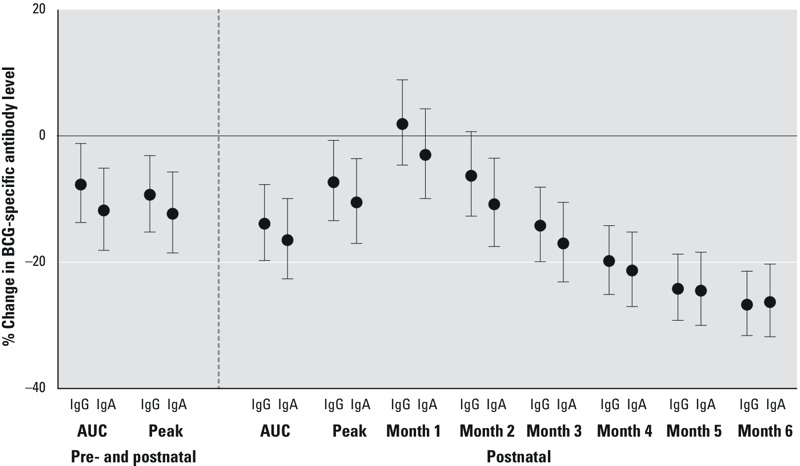
Estimated PCB concentrations from the physiologically based pharmacokinetic model (PBPK) and the percent change (95% CI) in 6-month BCG-specific IgG and IgA levels for an interquartile range difference in each PCB exposure. Pre- and postnatal models are adjusted for maternal ethnicity, education, age, smoking, and parity, and postnatal models are adjusted for maternal ethnicity, education, and age. Interquartile ranges as well as crude and adjusted numerical estimates are available in Table S2.